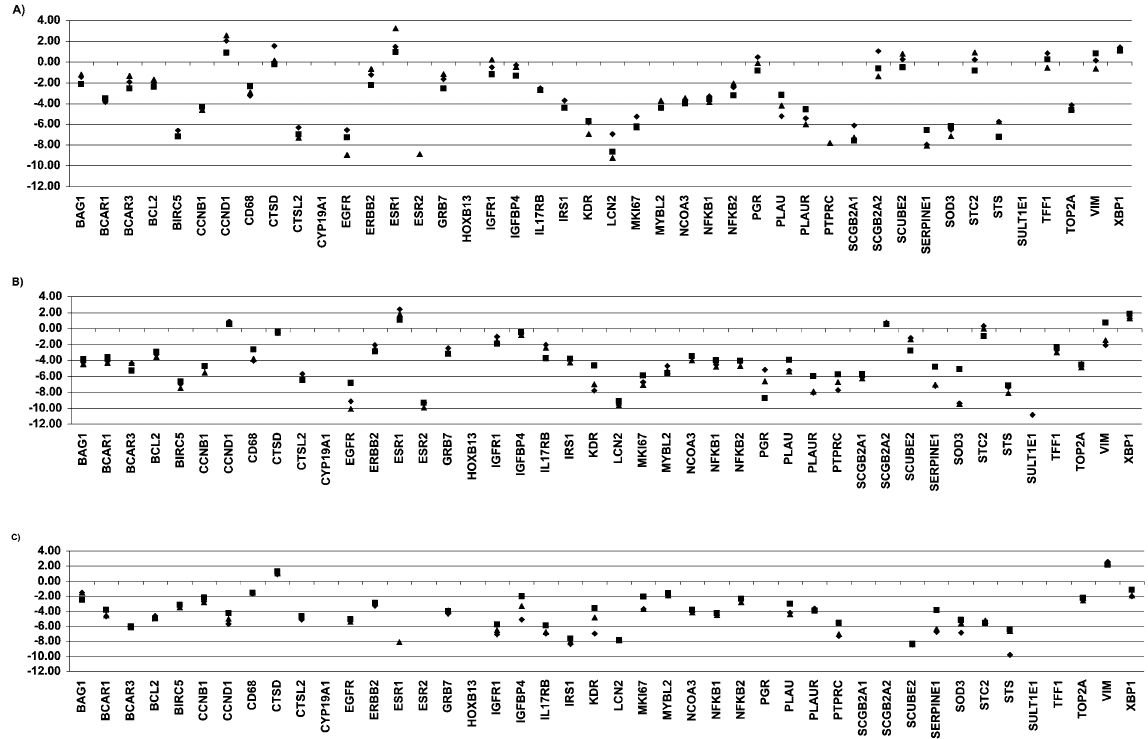
Fig. 5. Normalized gene expression ( ∆ Ct) values obtained by FNAs or tissue biopsy samples for the 44 individual genes. Three representative patients shown: (A) no. 7 (ER+), (B) no. 9 (ER+) and (C) no. 12 (ER − ). F FNA-A, Q FNA-B and 2 the tissue